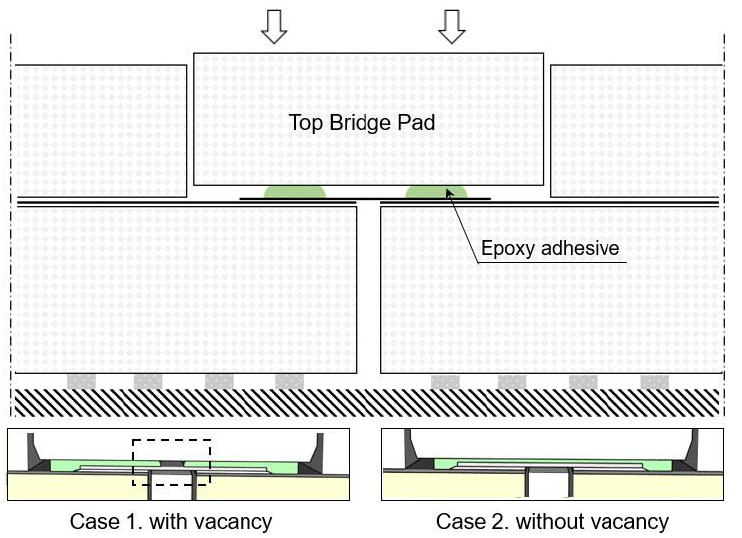
Figure 3. Schematic illustration of the manufacturing (bonding)-process-dependent adhesive vacancy in Mark III – type LNG insulation systems.